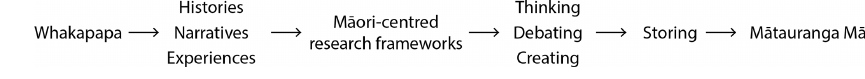
Figure 2. Generation of M¯aori knowledge. Modified from Graham